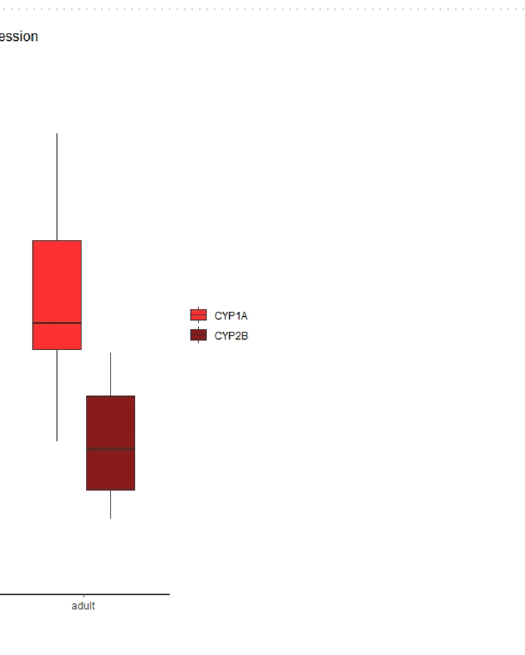
Figure 5. Boxplots showing CYP1A1 and CYP2B expression (pmolCYP/mg protein) in juvenile (n = 4), subadult male (n = 8) and adult male (n = 6). Error bars represent standard errors